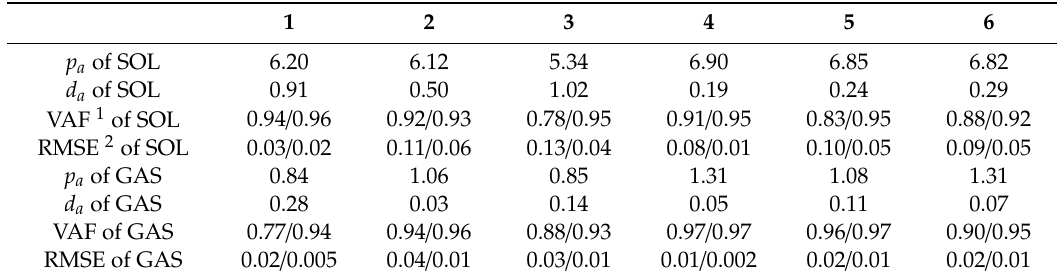
Table 1. SOL and GAS reflex gains of subject A of six trials.